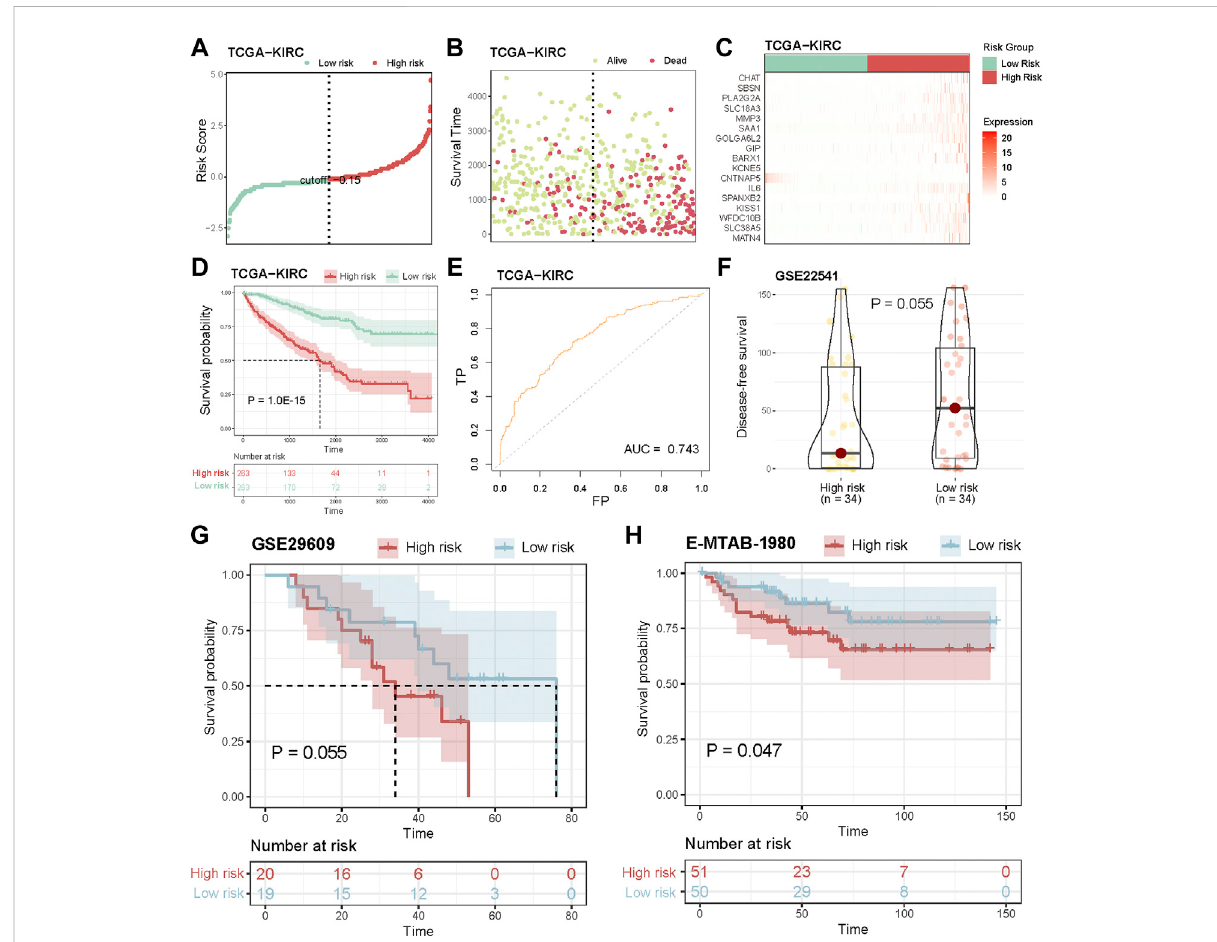
FIGURE 5 Validationoftheprognosticmodel. (A) Rankeddotshowsthedistributionofriskscore. (B) Scatterplotsshowsthedistributionofpatientsurvival status. (C) Heatmap shows the expression of 17-genes of prognostic model. (D) Assessment of the difference in OS between high risk and low risk samples in TCGA cohort by log-rank test. (E) ROC curves to predict the sensitivity and speci fi city of 3-years survival according to the risk score. (F) Distribution of DFS between high risk and low risk groups in GSE22541 cohort. (G,H) Kaplan-Meier curves show the independent relevance between overall survival time and risk score in GSE29609 and E-MTAB-1980